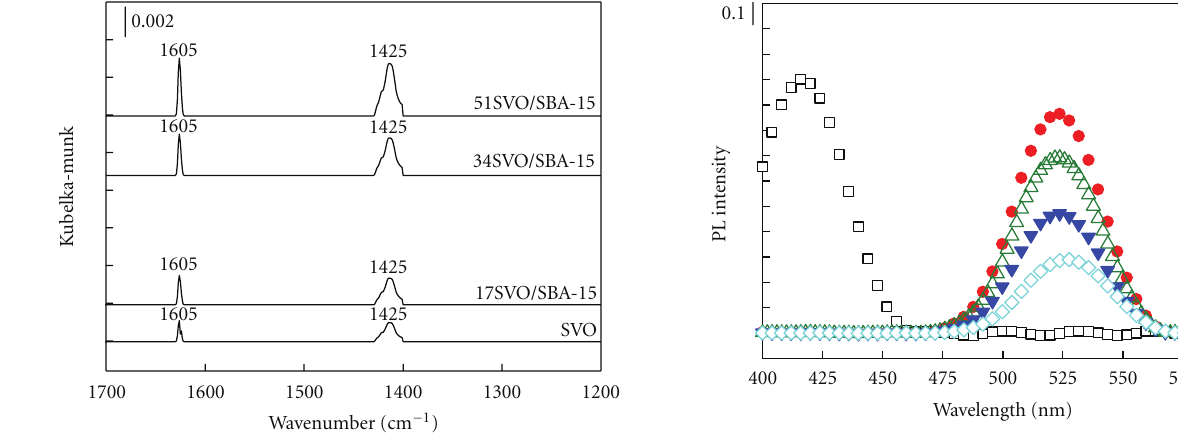
Figure 7: IR spectra of NH 3 adsorbed onto SVO and SVO/SBA-15 samples at 523 K.